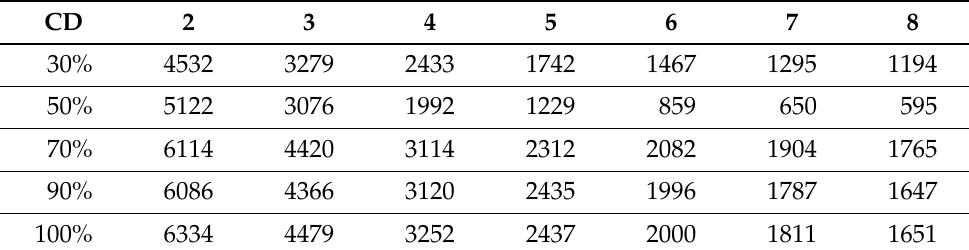
Table 1. AV 20 value over all the failure scenarios when varying the number of IEDs in (2–8). CD